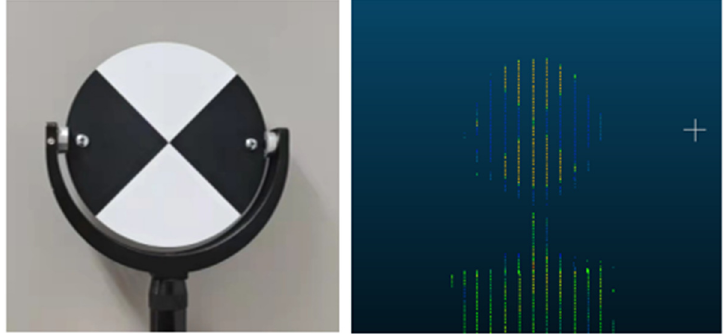
Figure 20. Target photo ( left ) and Point cloud extraction target ( right ).